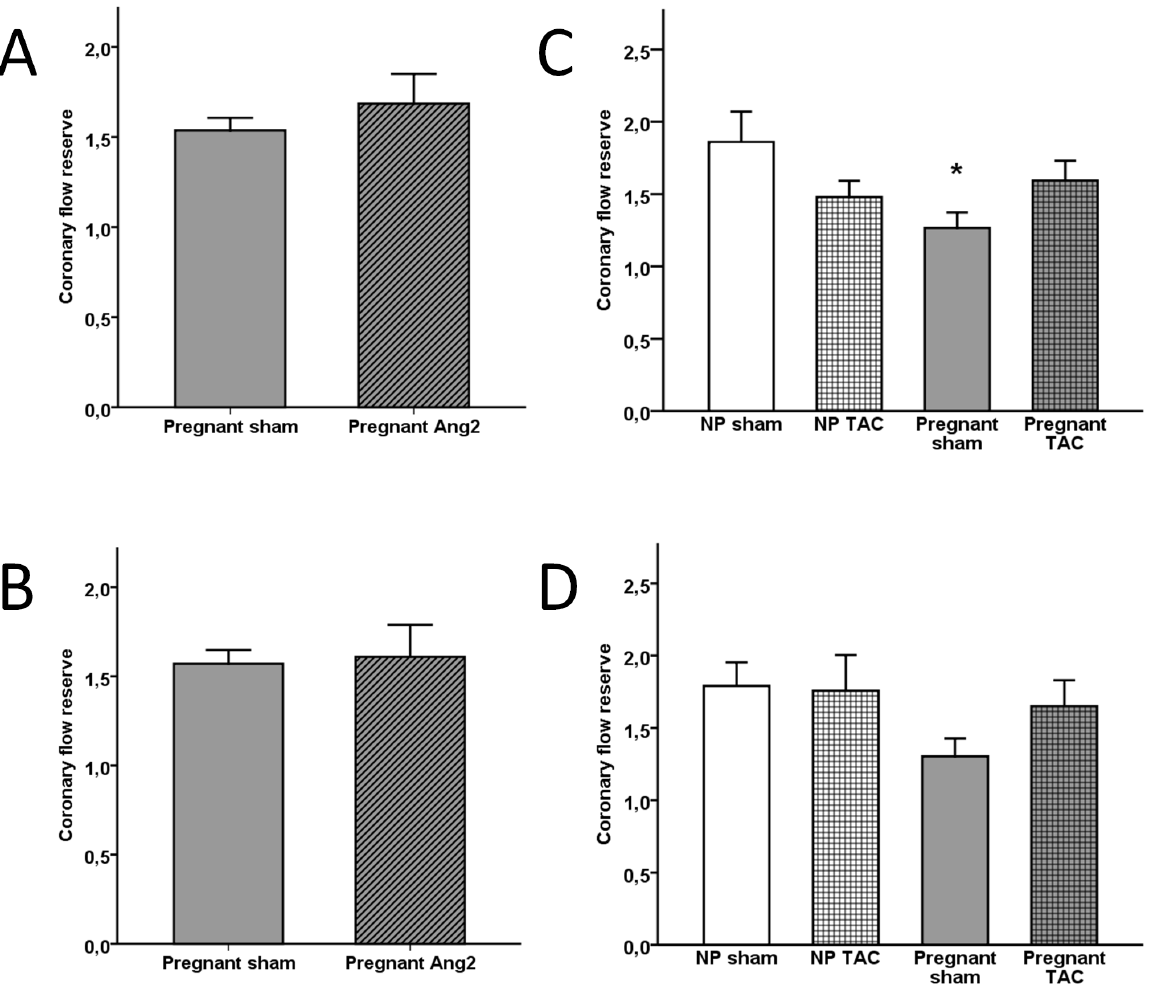
Figure 2. Coronary flow reserve in pregnant and non-pregnant rats. Mean 6 SEM for coronary flow reserve calculated from peak velocities (A, C) and velocity time integrals (B, D). Comparisons between groups were made using independent samples T-test (A, B) and one-way ANOVA and Holm-Sidak post hoc test (C, D). SEM, standard error of the mean, NP, non-pregnant, Ang2, Angiotensin II, TAC, transverse aorta constriction, p , 0.05 compared to non-pregnant sham (*).